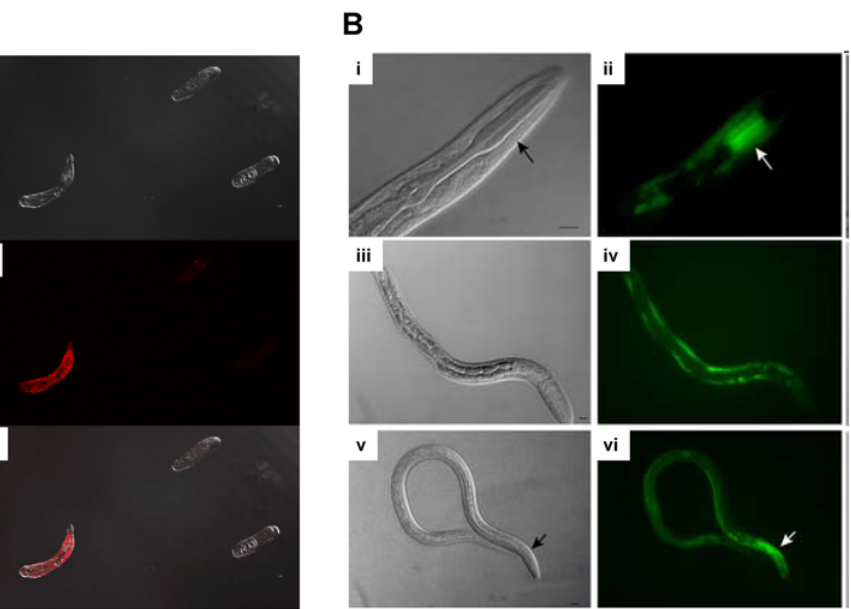
Figure 3. Some recent approaches to expressing transgenes in human helminths. (A) Luciferase activity in Schistosoma mansoni larvae (schistosomules) after transduction with a pseudotyped retrovirus that expresses the luciferase reporter gene. Anti-luciferase antibody staining of schistosomules three days after exposure to pseudotyped lentivirus carrying the firefly luciferase transgene. Schistosomules examined by confocal laser microscopy; (i) bright field, (ii) fluorescence red channel, (iii) merged images. Control non-transformed worms showed only background levels of fluorescence (not shown; see [34–36] for relevant hypotheses and experimental methods). (B) Recent studies on transgenic Strongyloides stercoralis indicated that morphogenesis of the infective L3 stage larva requires the DAF-16 orthologue FKTF-1 [38]. L3s of this parasitic nematode were transfected with plasmids carrying the transgene fktf-1 b ::gfp::fktf-1b and examined by fluorescence microscopy. (i, ii) Transgenic first-stage larvae express green fluorescent protein (GFP) in the procorpus (arrow) of the pharynx. (iii, iv) A first-stage larva (L1) expresses the GFP::FKTF-1b(wt) transgene in the hypodermis. (v, vi) An infective L3 expresses the GFP::FKTF-1b(wt) fusion protein in the hypodermis and in a narrow band in the pharynx (arrow). Scale bars, 10 m m. Adapted from